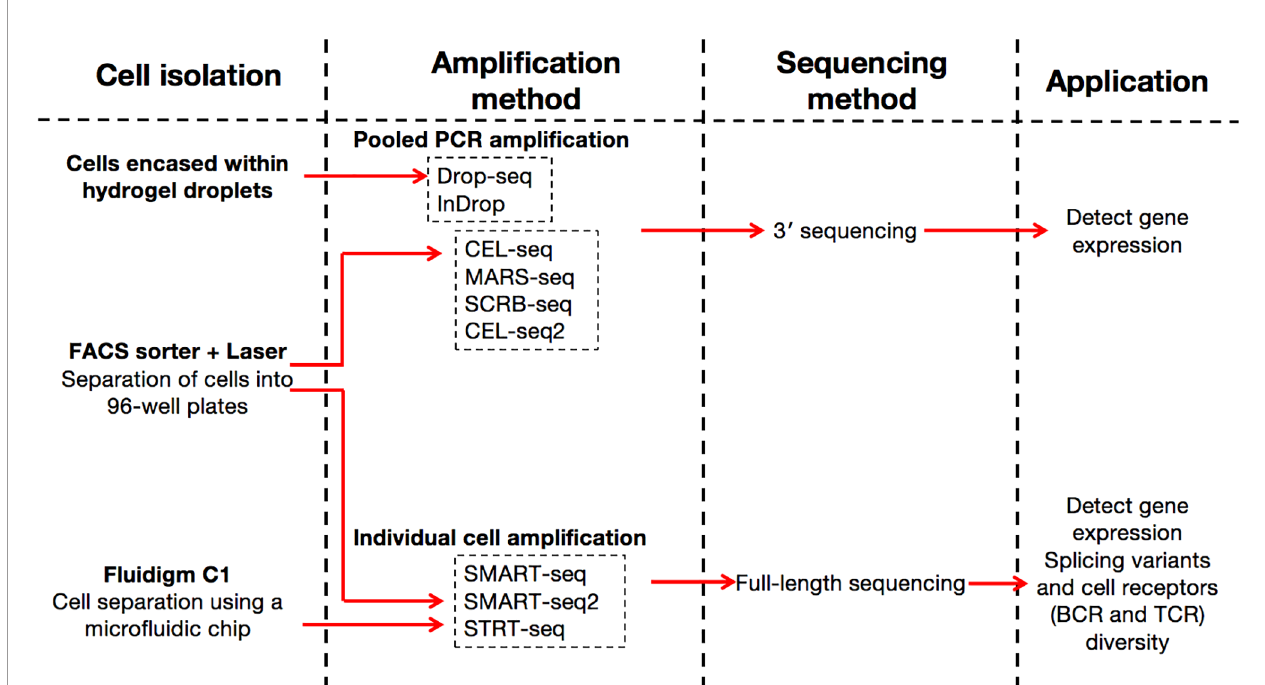
FIGURE 1 | Principle of single-cell sequencing technologies. SCRB-seq, single-cell RNA barcoding and sequencing; BCR, B-cell receptor; TCR, T-cell